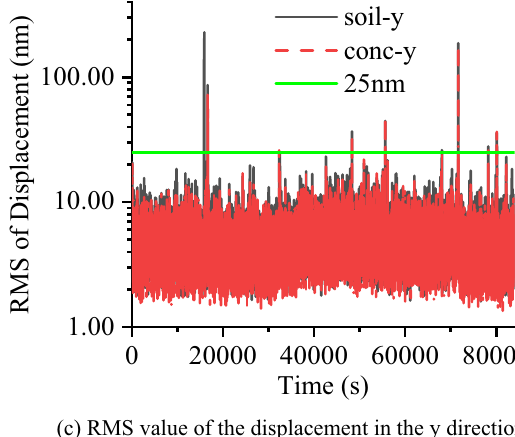
Figure 17. Displacement RMS value at each second over 24 h.